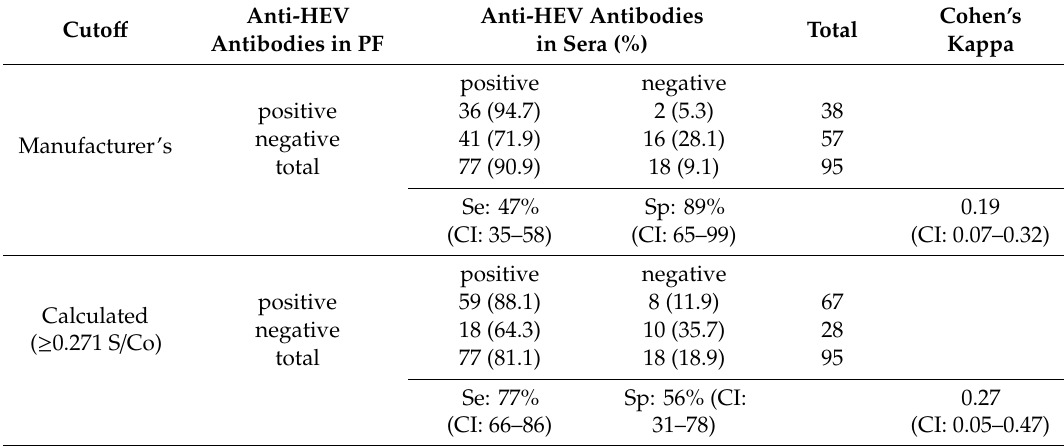
Table 2. Agreement between processing fluids (PF) and sera-based HEV ELISA results at the individual level.